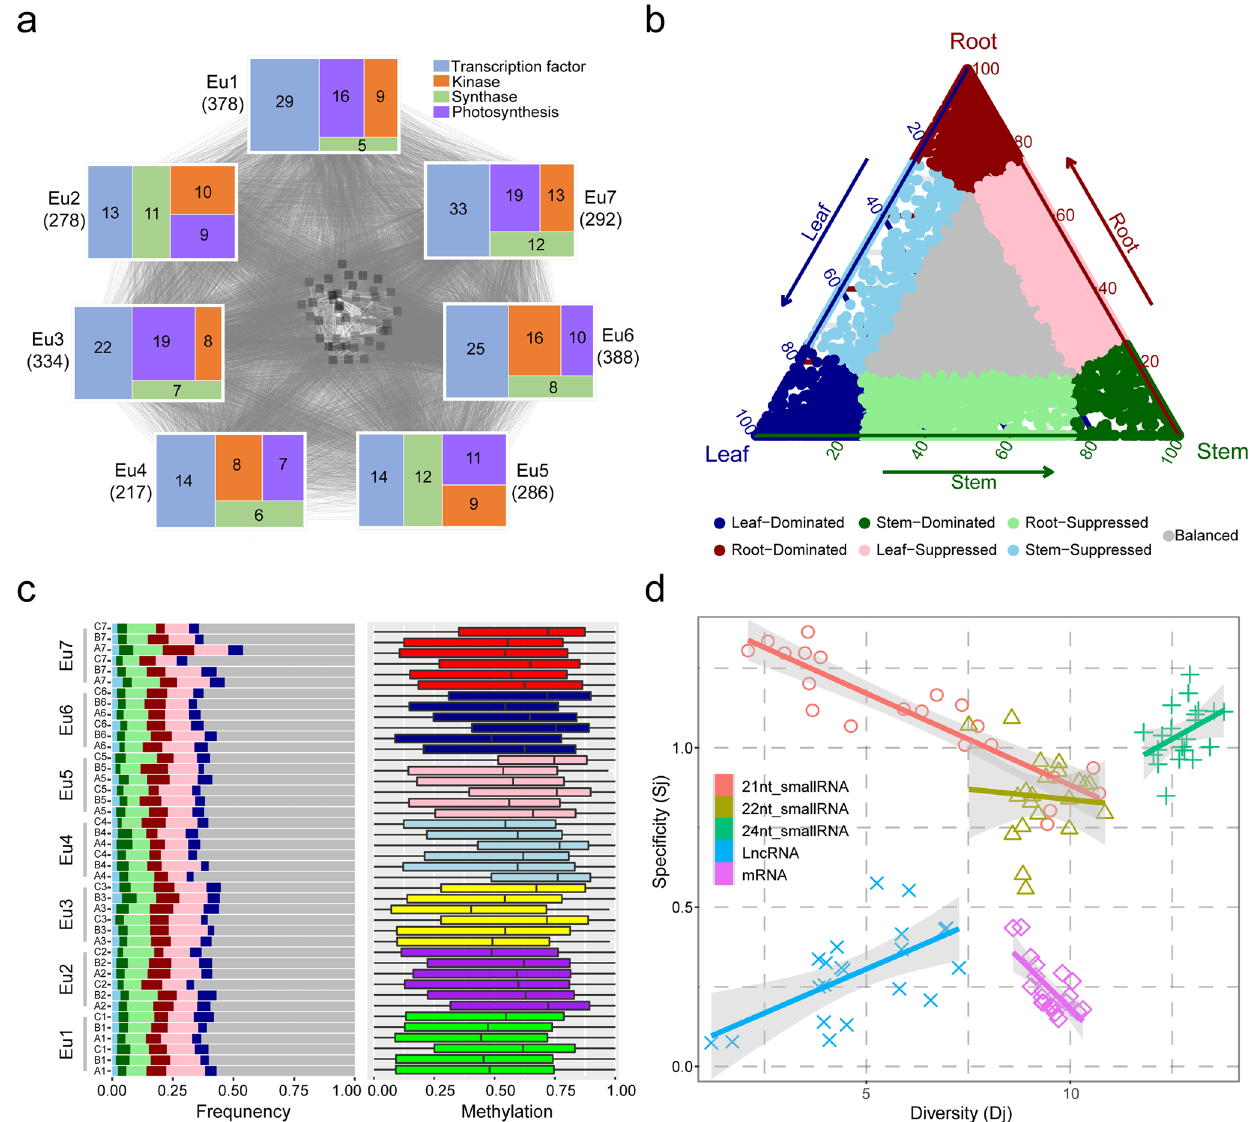
Fig. 4 Evolutionary dynamics of the ancestral core-eudicot genes in extant Panax stipuleanatus genome. a Co-expression network of the ancestral core- eudicot genes involved in the leaf development in extant P. stipuleanatus species. Eight gene clusters were de fi ned according to their originations. Eu1 – Eu7 are the seven ancestral core-eudicot chromosomes. Numbers below each ancestral chromosome (Eu1 – Eu7) are the total identi fi ed ancestral genes. Gray dots in the middle are the ancestral genes that cannot be unassigned to the seven ancestral chromosomes. Gray lines indicate the ancestral gene interaction. Colors and numbers represented the functions and numbers of ancestral genes involved in the leaf development. b Ternary plot of expression patterns of ancestral genes in extant P. stipuleanatus genome. Each circle is a triad showing relative expression abundance in leaf, root and stem tissues for each ancestral gene. Triads in vertices correspond to the three tissue-dominant expression categories, whereas triads close to edges and between vertices correspond to three tissue-suppressed expression categories. Balanced triads are shown in gray. c Percentage of triads in each category of the ancestral genes (left) and boxplot of cytosine methylation for the ancestral genes (right). The 42 bars from top to bottom represent the duplicated ancestral core- eudicot chromosomes (Eu1 – Eu7). Each ancestral chromosome contains six homologous genomic regions in extant P. stipuleanatus genome. Colors of the seven types of genes and names of each ancestral chromosome are the same as in Fig. 1. All ancestral genes identi fi ed in the 42 genomic regions were used to the statistical analyses. In right panel, the lower and upper whiskers of each colored box are the lowest (0.00) and highest (1.00) cytosine methylation level, respectively. The black solid lines within each box are media values. Lengths of the boxes are the interquartile range. d Expression dynamics of the protein-coding genes and non-coding RNAs of the 42 duplicated ancestral chromosomes in the leaf, root, and stem tissues. X - and Y -axis are expression diversity (Dj) and speci fi city (Sj) of the ancestral genes. Each symbol represents an ancestral chromosome. Differences in Dj and Sj values indicate high expression diversity among the ancestral chromosomes and expression speci fi city among the three tissues. The edges of each shade area are the error bands. Source data are provided as a Source Data fi The above observations indicate that while the genomic regions duplicated genomic regions had similar functional contributions duplicated from the same ancestral core-eudicot chromosome to the tissue development of extant Panax species. We then (Eu1 – Eu7) showed dramatic biased genetic fractionation and examined whether the genes retained within these duplicated divergence in epigenetic regulation, genes retained on each of the ancestral core-eudicot chromosomes were involved in similar